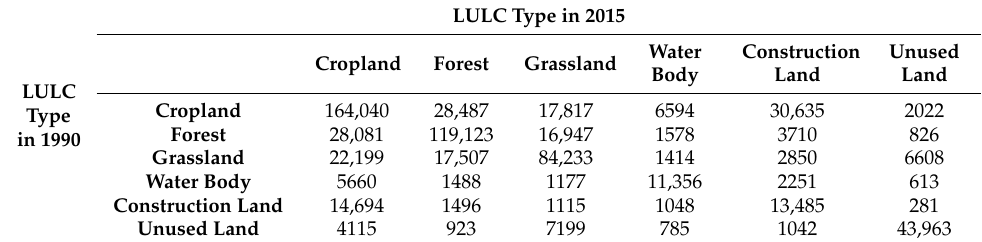
Table 3. Change matrixes of each compared LULC types from 1990 to 2015 (Km 2 ).